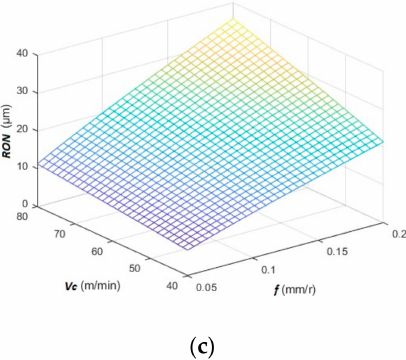
Figure 16. Potential models for ( a ) STR = g ( v c , f ), ( b ) CRO = h ( v c , f ) and ( c ) RON = j ( v c , f